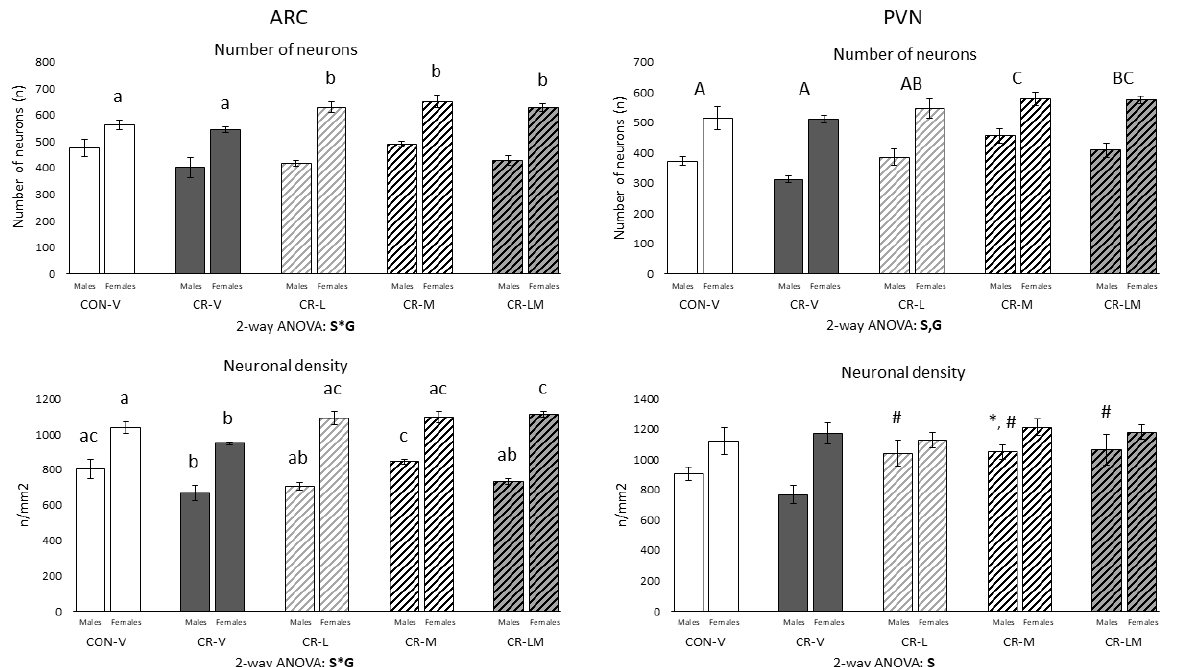
Figure 1. Number of neurons and neuronal density in the arcuate (ARC) and paraventricular (PVN) nuclei of the hypothalamus of 25-day-old male and female offspring of control (CON) and 25% gestational calorie-restricted (CR) dams. Data are means ± s.e.m ( n = 5–7). Statistics: Two-way ANOVA was performed to assess the effects of sex and group (CON-V, CR-V, CR-L, CR-M, and CR-LM). One-way ANOVA was carried out to determine differences between groups in each sex separately when previous two-way ANOVA showed interactive effect between sex and group. ANOVA was followed by a least significant difference (LSD) post-hoc test. Mann–Whitney U test was used for single comparisons between groups. Symbols: S, effect of sex; G, effect of group; S*G, interactive effect between sex and group; A ≠ B ≠ C ( p < 0.05, two-way ANOVA); a ≠ b ≠ c ( p < 0.05, one-way ANOVA); *, different from their respective CON-V group; #, different from their respective CR-V group ( p < 0.05, Mann–Whitney U test). Abbreviations: vehicle (V), leptin (L), myo-inositol (M), leptin and myo-inositol (LM).